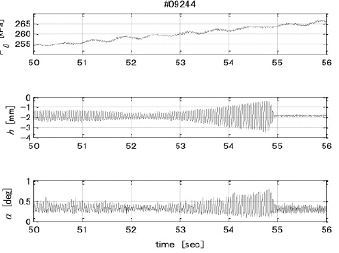
Figure 9. Time history of a total pressure of the flow; P displacement; h and a pitch angle; α at flutter (#09237).